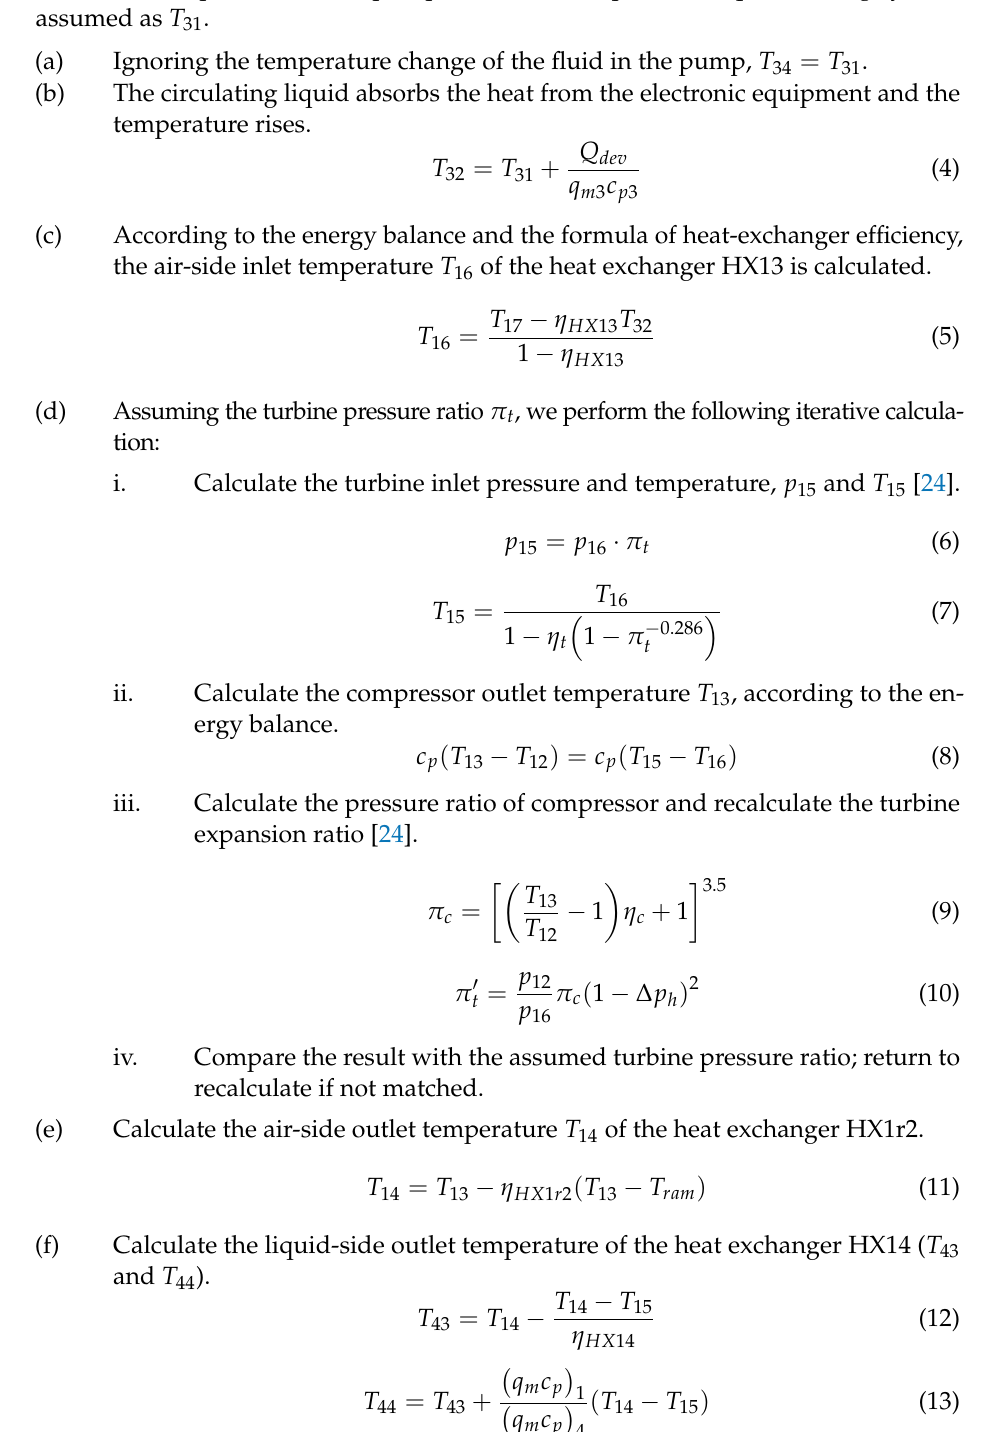
3. The outlet temperature of the pump in the low-temperature liquid-cooling cycle is assumed as T 31 . Ignoring the temperature change of the fluid in the pump, T 34 = T 31 . The circulating liquid absorbs the heat from the electronic equipment and the temperature rises.